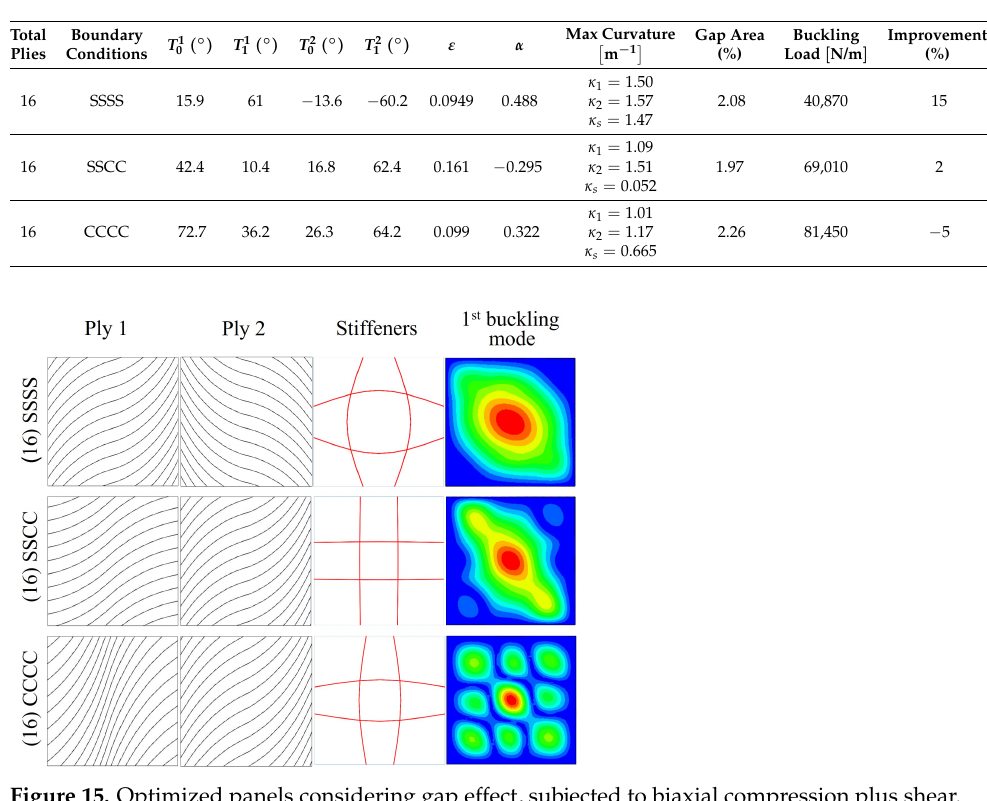
Figure 14. Optimized ideal panels subjected to biaxial compression plus shear. Table 8. Optimization results of panels considering gap effect, subjected to biaxial compression plus shear load.